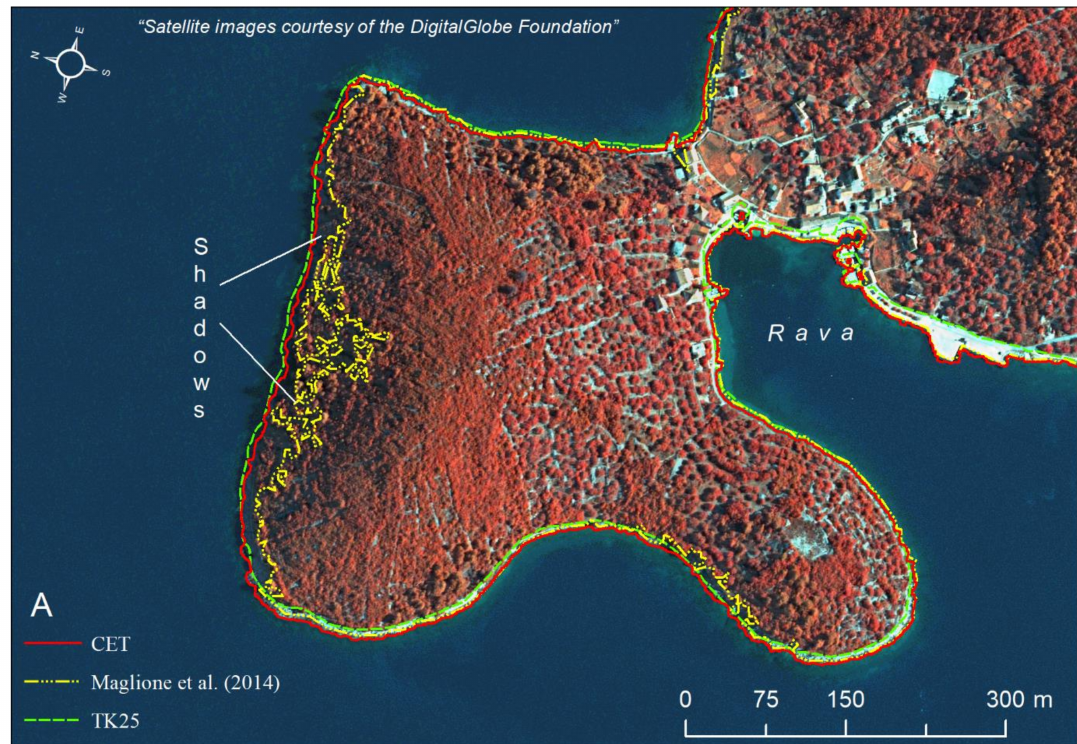
Figure 12. Successful automated extraction of coastline over significantly shaded areas.